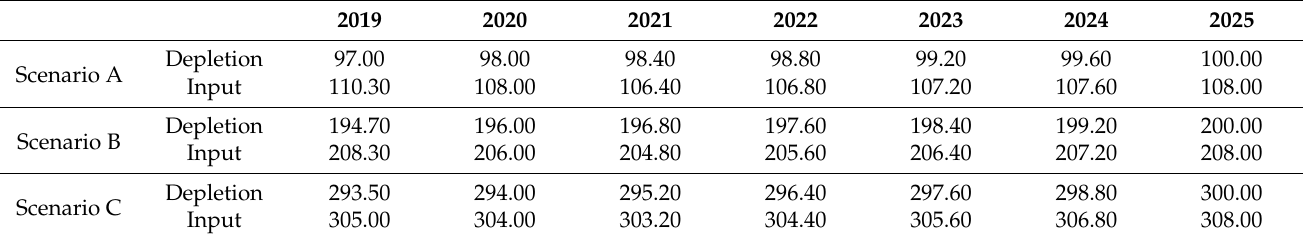
Table 3. Input and depletion of bicycle-sharing in